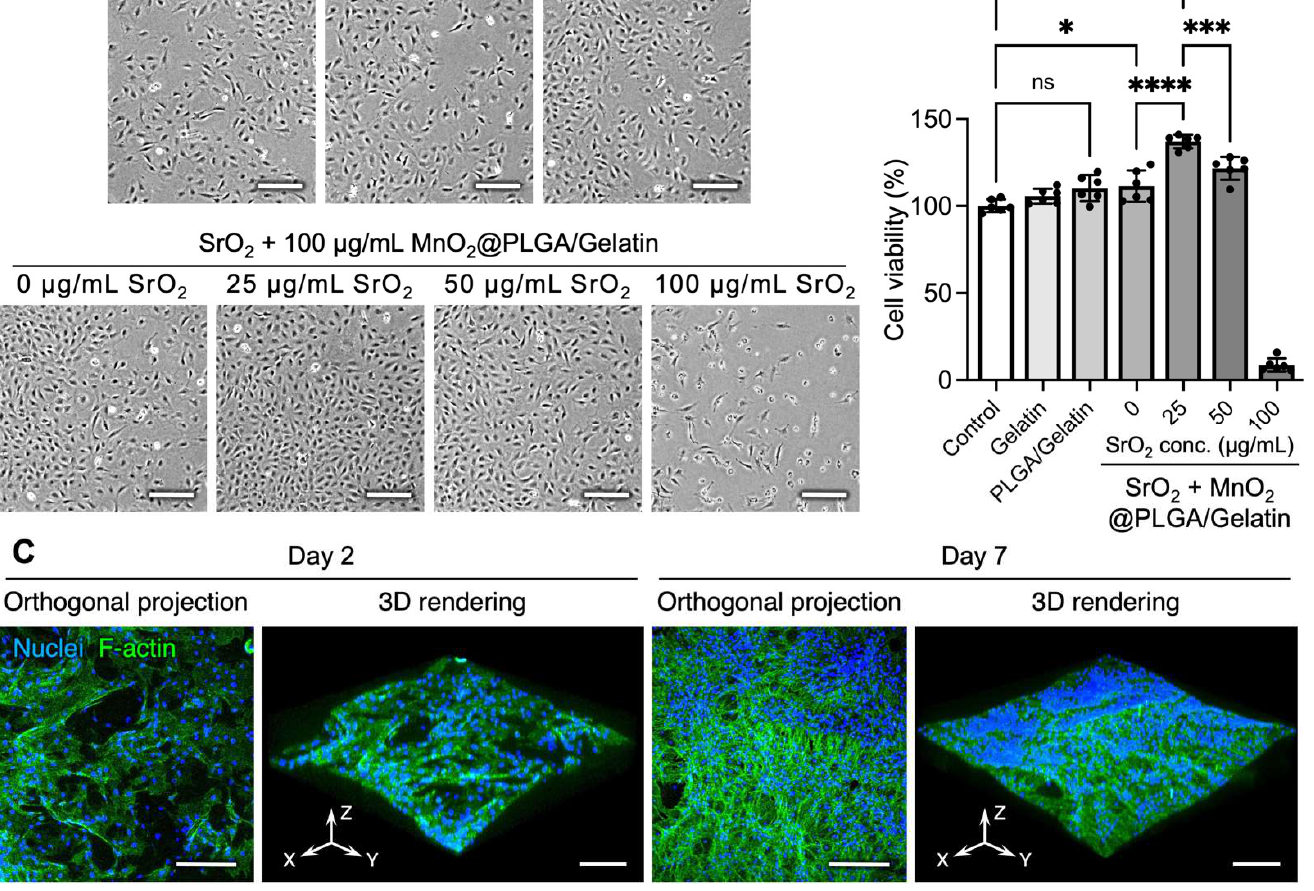
Figure 3. SrO 2 + MnO 2 @PLGA/gelatin scaffolds promote the proliferation of preosteoblasts. ( A ) Representative phase contrast photomicrographs of MC3T3-E1 preosteoblasts that received various treatments and ( B ) the corresponding cell viability determined using a CCK-8 assay ( n = 6). Scale bars, 200 µm. * p < 0.05; *** p < 0.005; **** p < 0.001; ns, not significant. Data are the mean ± s.d. ( C ) Representative orthogonal projection and 3D rendering of MC3T3-E1 cells grown on the scaffolds and incubated for two or seven days. Scale bars, 200 µm.